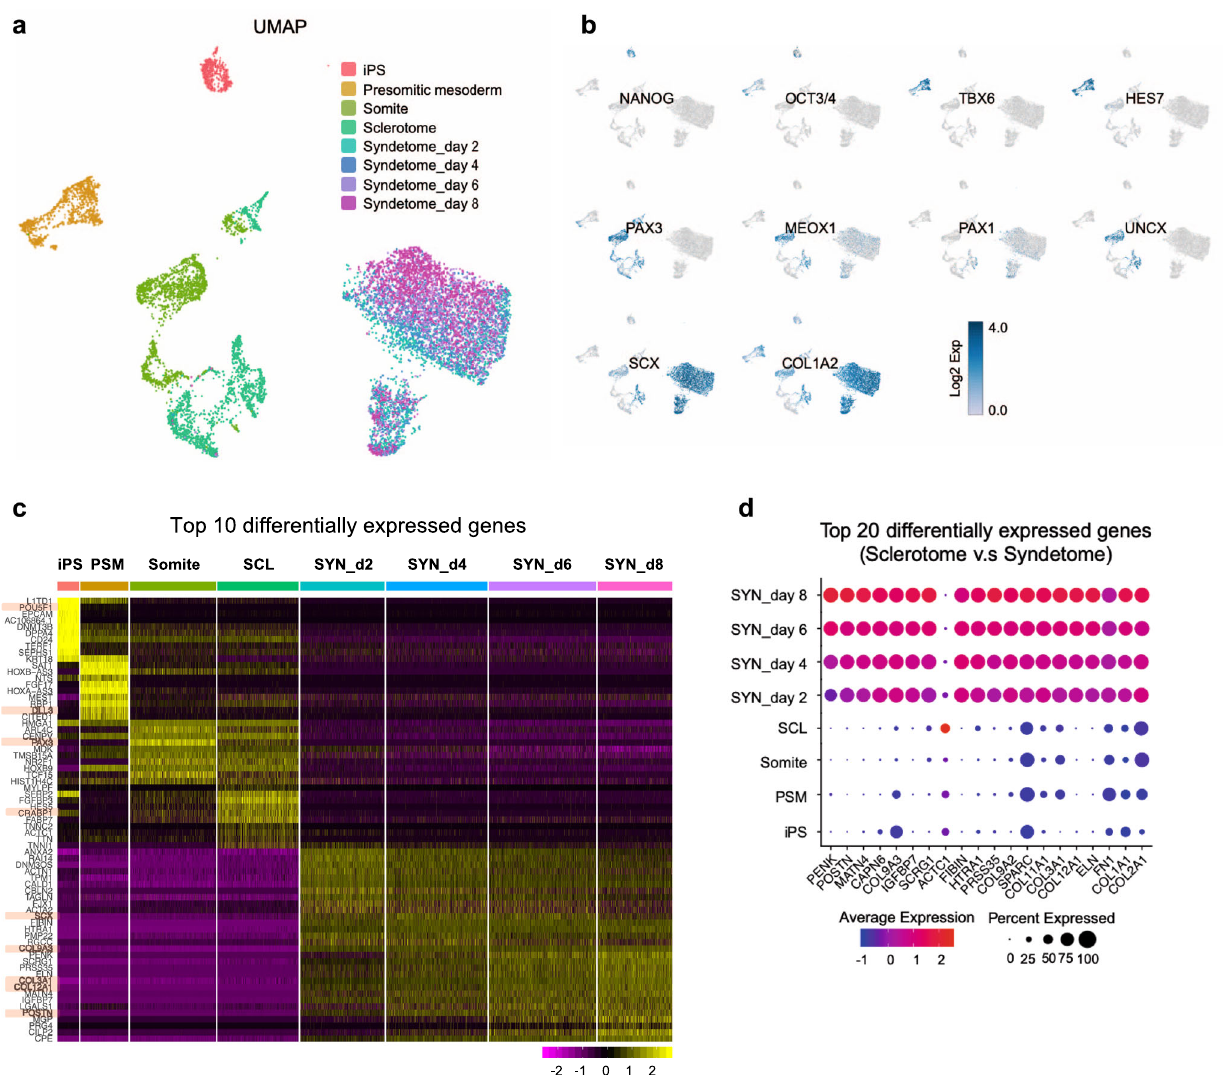
Fig. 2 Transcriptional dynamics throughout iPSC-syndetome differentiation. a , b Two-dimensional uniform manifold approximation and projection (UMAP) with combined data from all time points for iPSCs, presomitic mesoderm, somite, sclerotome, and syndetome ( a ). The expression of markers for iPSCs ( NANOG, OCT3/4 ), presomitic mesoderm ( TBX6 , HES7 ), somites ( PAX3 , MEOX1 ), sclerotome ( PAX1 , UNCX ), and syndetome ( SCX , COL1A2 ) ( b ). c Heatmap of the top 10 differentially expressed genes in each sample. Representative gene markers are labeled. d Dot plot of the top 20 differentially expressed genes in sclerotome vs. syndetome. PSM, presomitic mesoderm; SCL, sclerotome; SYN,